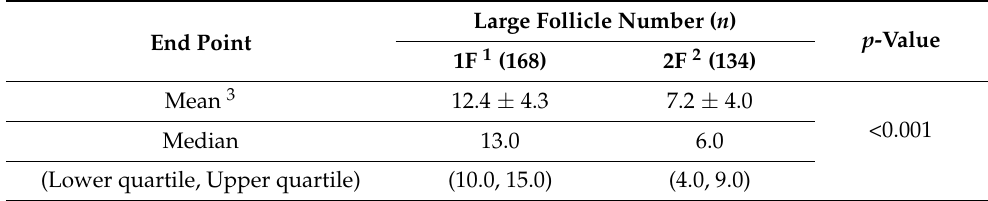
Table 2. Differences in mean and median days from the ovarian examination to the estrus between 1F 1 and 2F 2 .